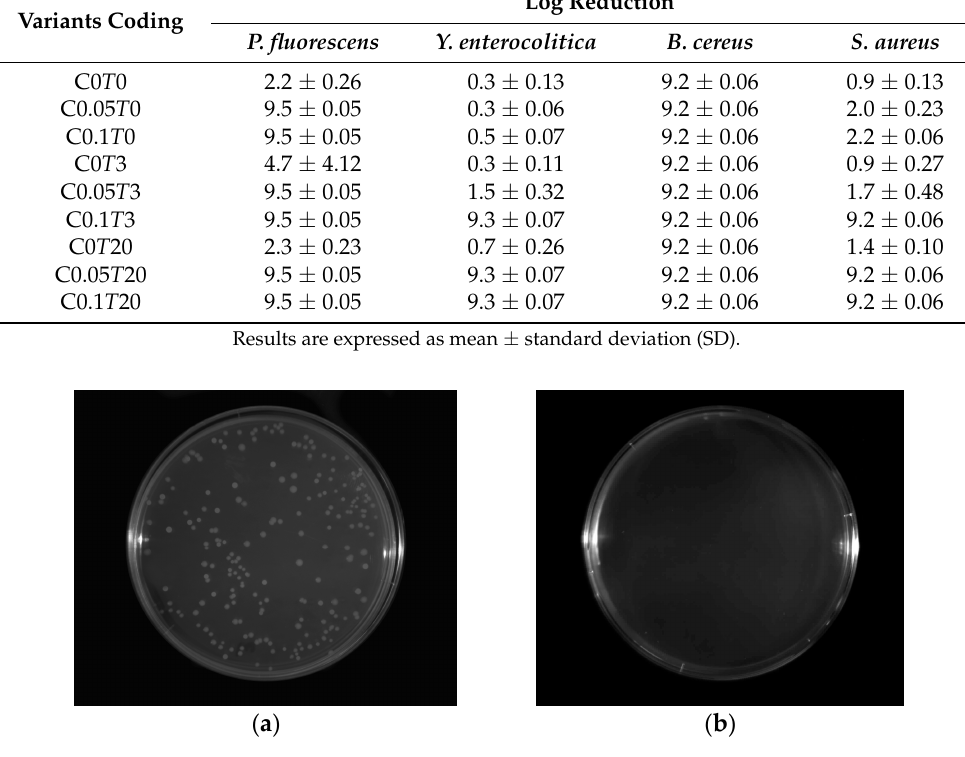
Figure 3. Antimicrobial effect: ( a ) growth of Y. enterocolitica (initial population); ( b ) inhibition of Y. enterocolitica growth with applied C0.1T20 hydrosol.